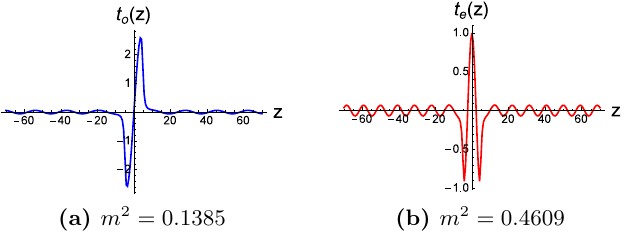
Figure 3. Plots of the (cid:12)rst even and (cid:12)st odd parity resonance modes for the single brane model (3.1). The parameters are set to k = 1, b = 10, and m 2 = 0 : 1385 for t o ( z ), and m 2 = 0 : 4609 for t e ( z